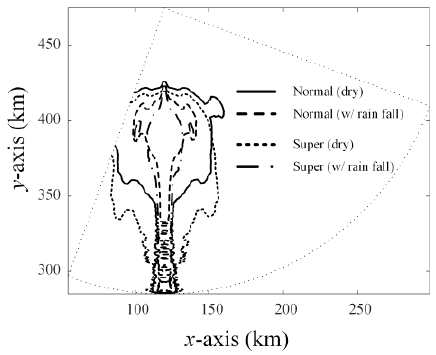
Figure 8. Simulation results of the TDP along the range and the azimuth angle for the first scenario: ( a ) TDP in a super-refraction; ( b ) contour plots of TDP in an anomalous atmospheric environment; ( c ) detectable area results for TDPs over 80% and 90%.